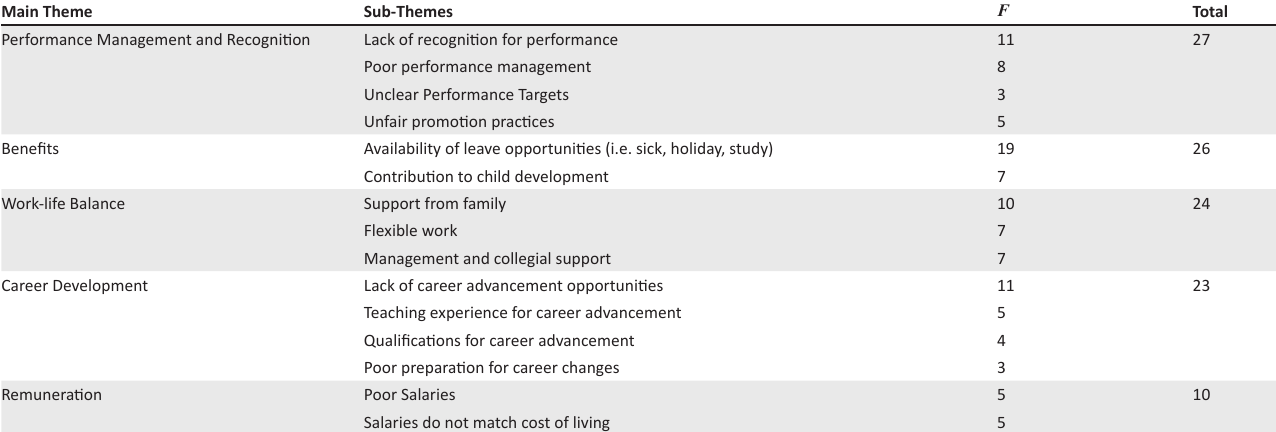
TABLE 2: Categories of main and sub-themes. Main